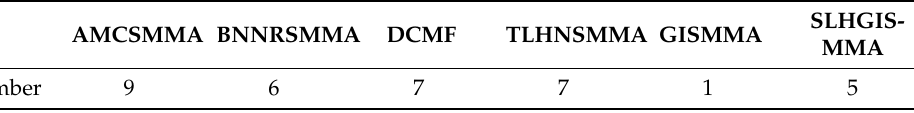
Table 6. The number of confirmed SM–miRNA associations in the top 20 associations predicted by AMCSMMA and other models separately.